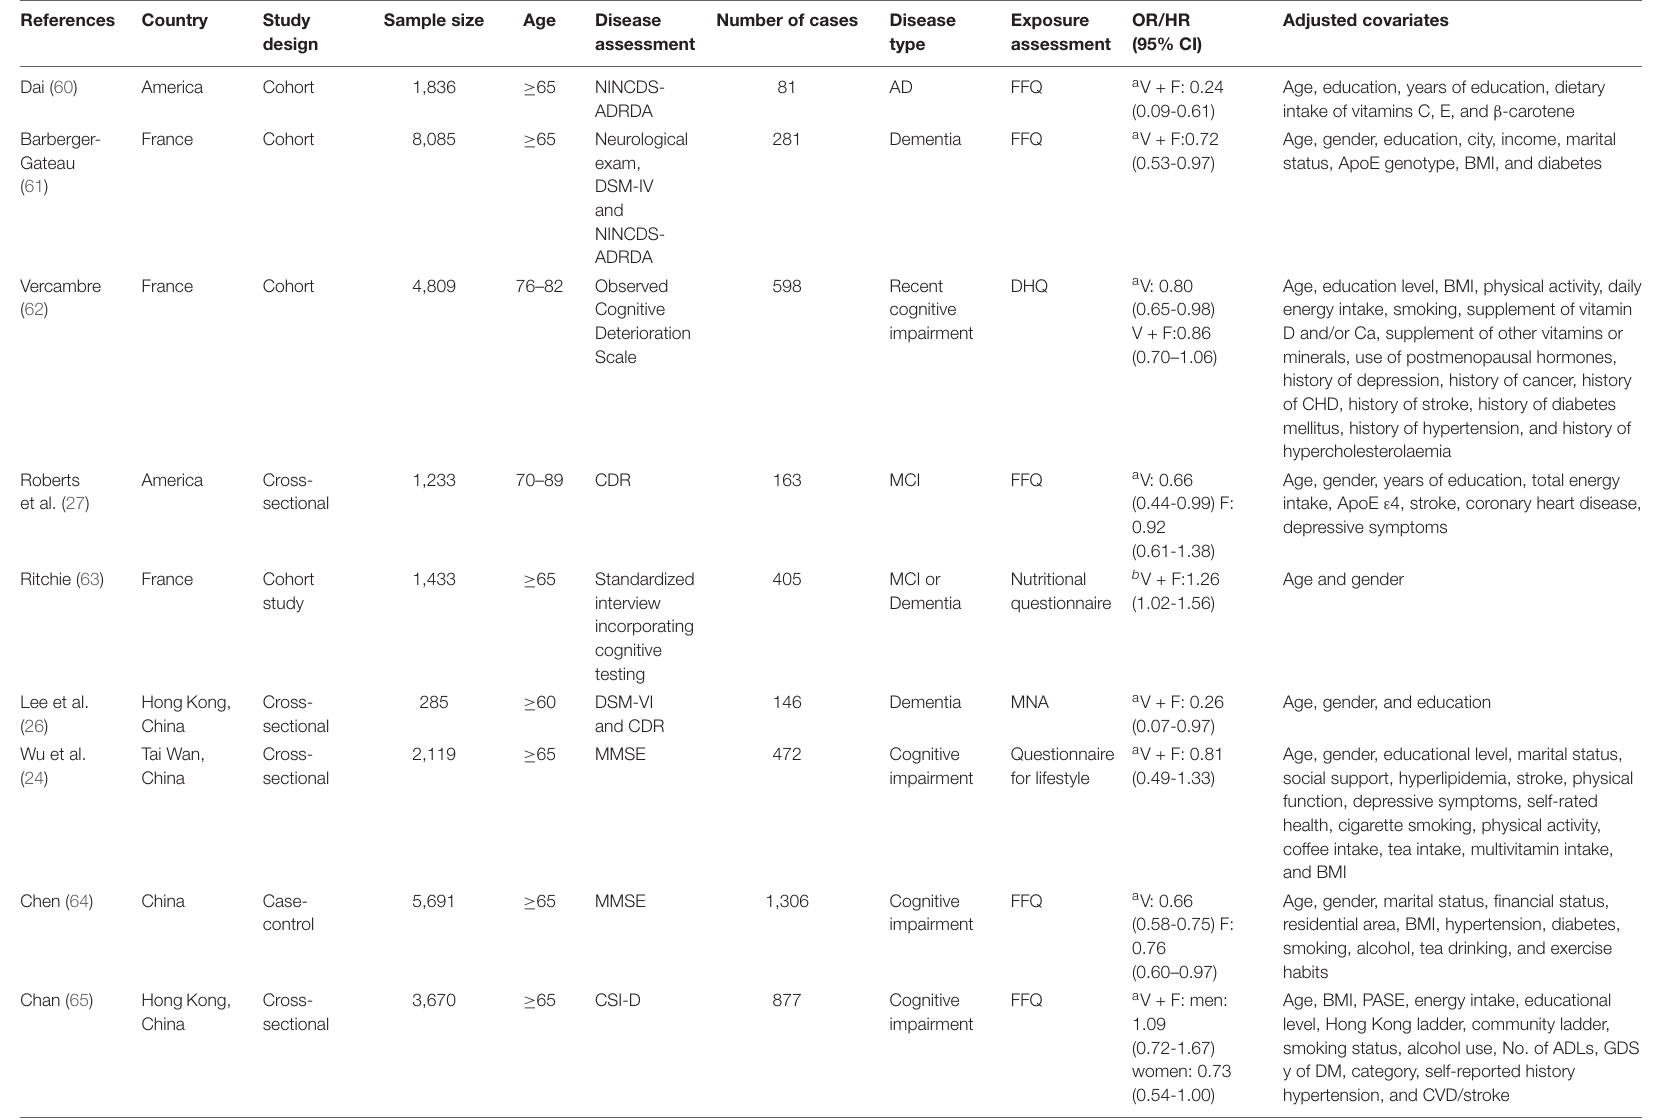
TABLE 1 | Characteristics of the included studies in this